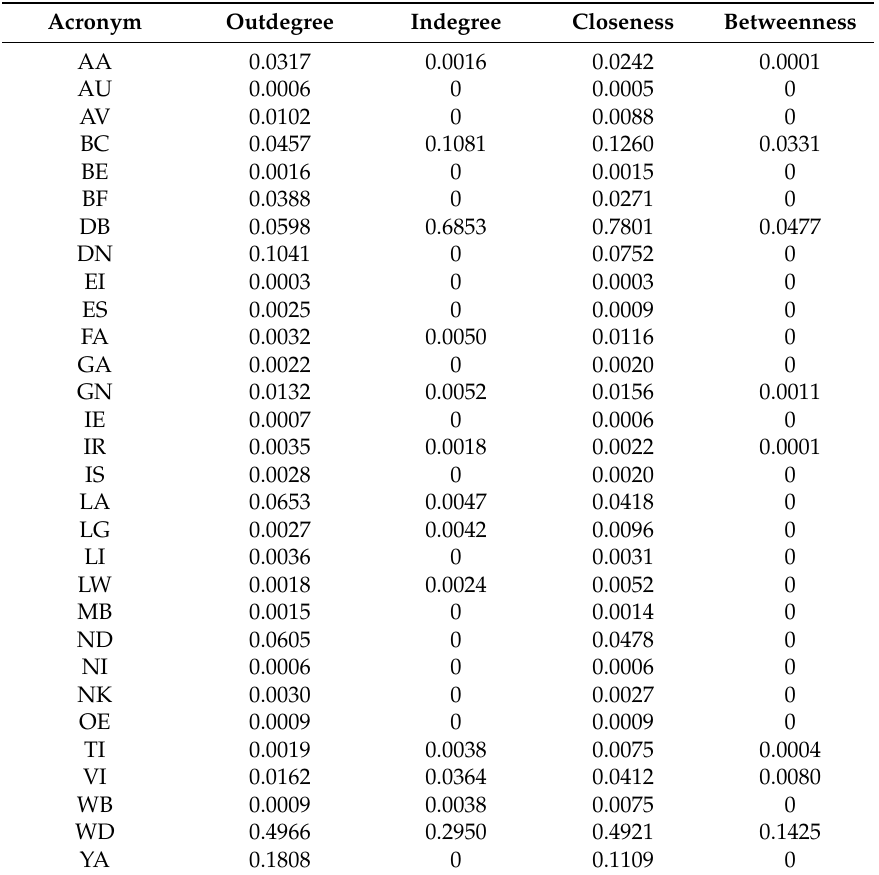
Table 2. Average centrality values of semantic